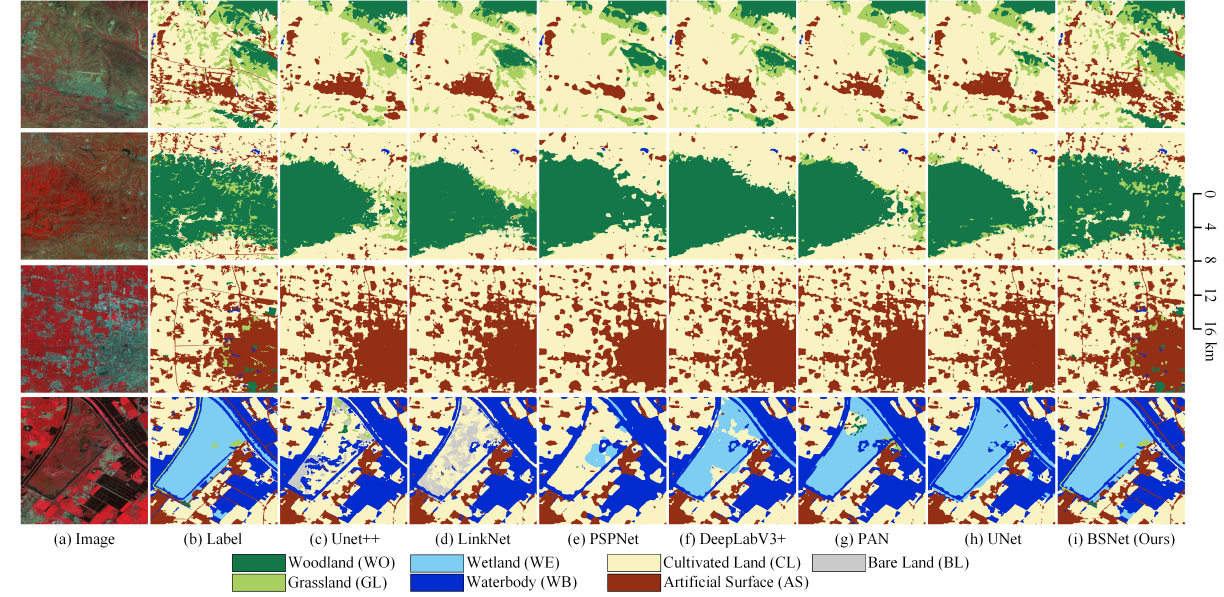
Figure 15. Some examples of the results on the Landsat extend dataset. Comparison between our BSNet and other methods. ( a ) Landsat image. ( b ) Ground truth. Inference result of ( c ) the UNet++, ( d ) the LinkNet, ( e ) the PSPNet, ( f ) the DeepLabV3+, ( g ) the PAN, ( h ) the UNet, and ( i ) our proposed